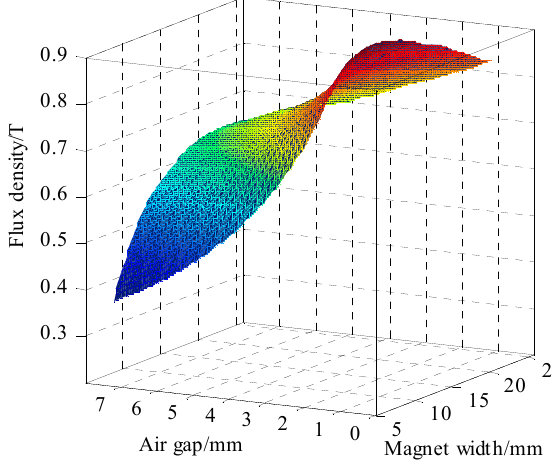
Figure 6. Air gap flux density.